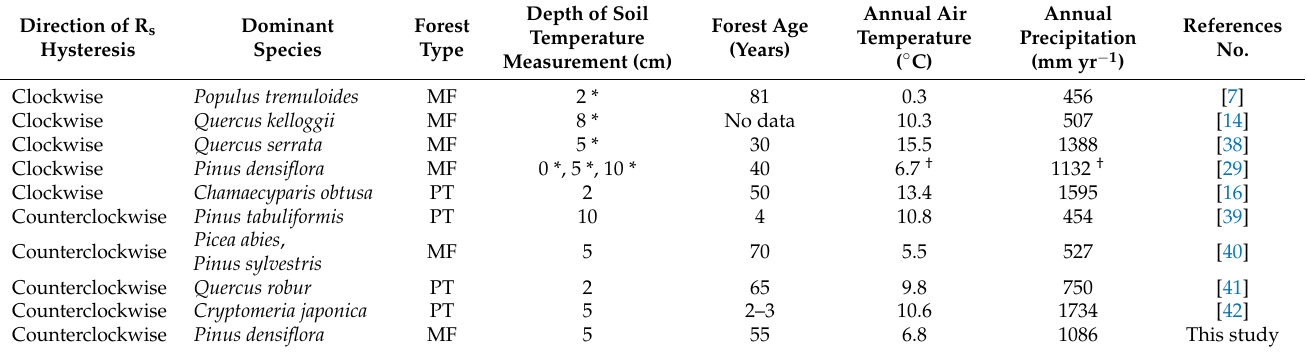
Table 1. Direction of soil respiration (R s ) hysteresis in temperate and boreal forest in previous